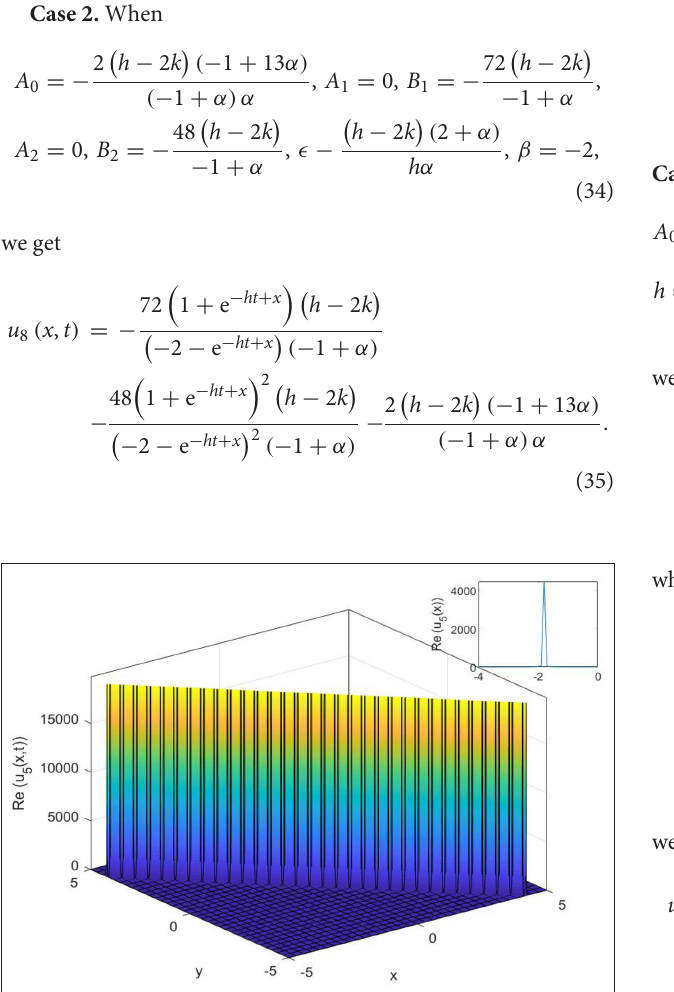
FIGURE 6 | The 3D, 2D, and contour surfaces of Equation (29) using µ